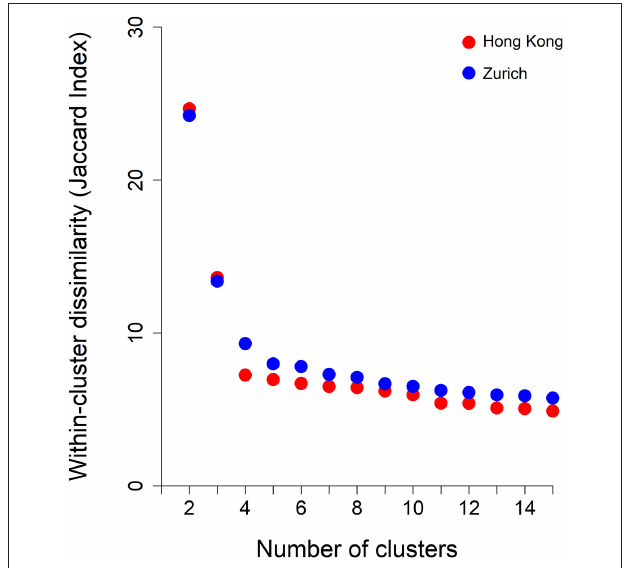
FIGURE 3 | Within-cluster dissimilarity index (measured by Jaccard Index) by number of clusters derived from hierarchical agglomerative clustering and by jurisdictions, i.e., Hong Kong and